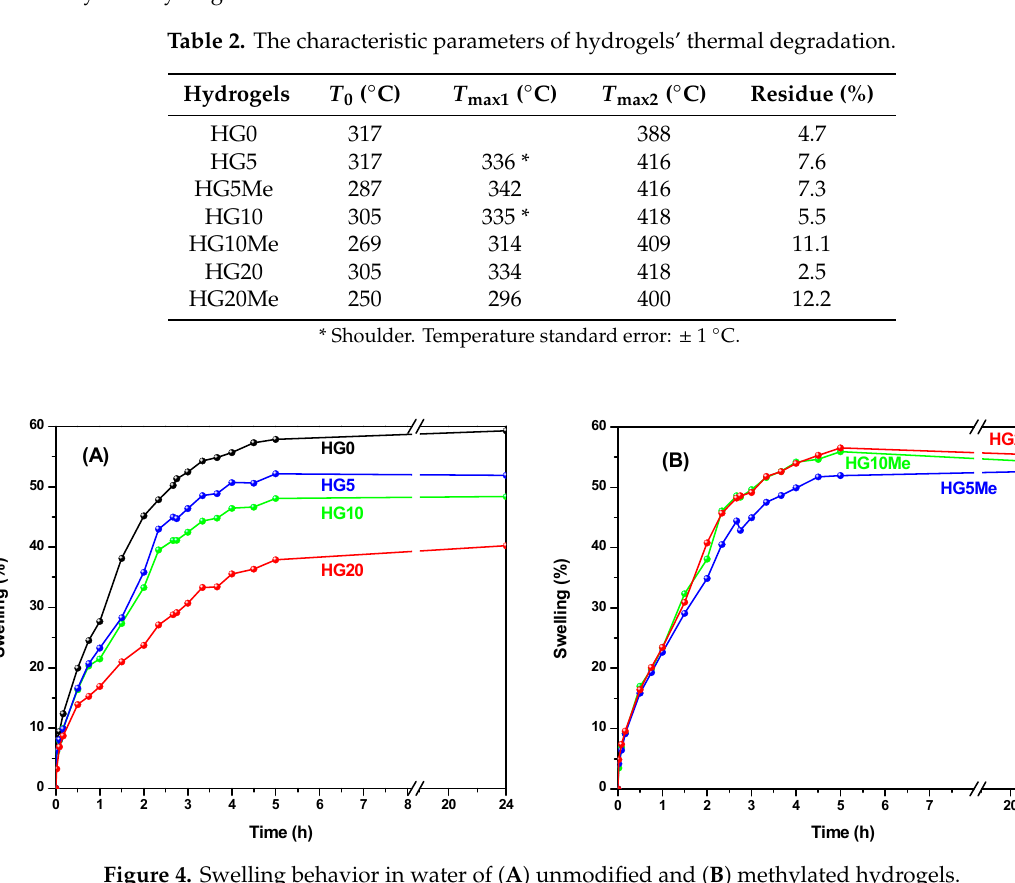
Figure 4. Swelling behavior in water of ( A ) unmodified and ( B ) methylated hydrogels.